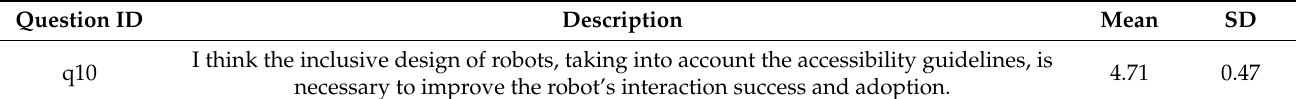
Table 6. Question evaluating societal impact factor. Table 4. Questions evaluating user experience factor.